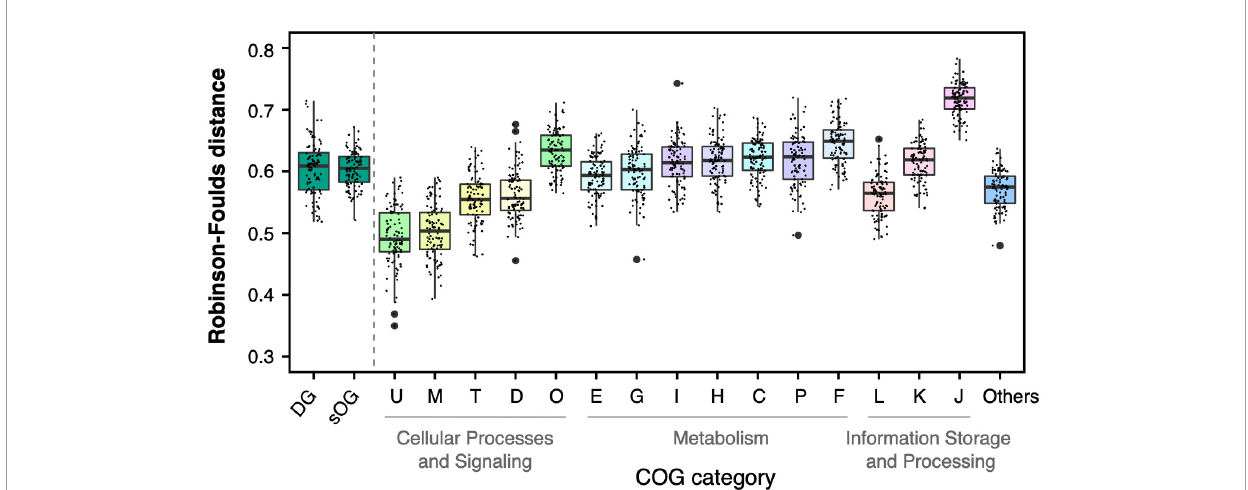
FIGURE4 Topological comparison between single-gene trees and species tree based on supermatrix (ST1). Each single data point represented a mean value of Robison-Foulds distances between single-gene trees in the corresponding dataset [e.g., genome dataset (DG)] to ST1 in one of 100 random genome datasets (RGDs).